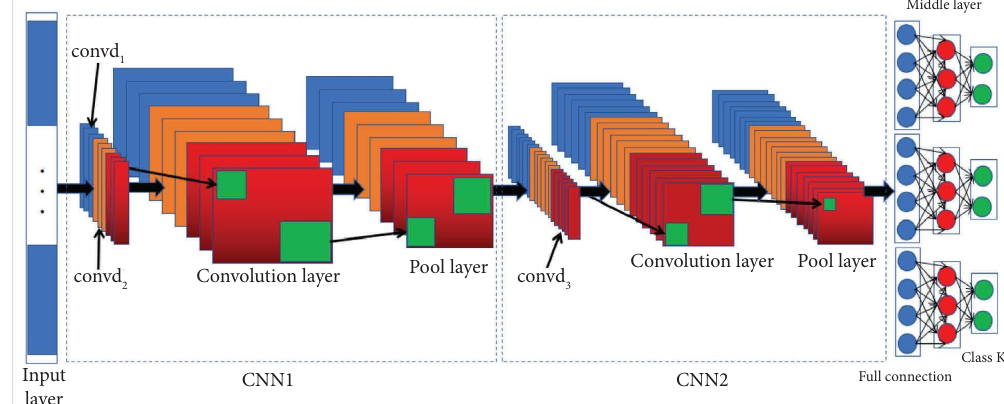
Figure 2: Structure of improved CNN.